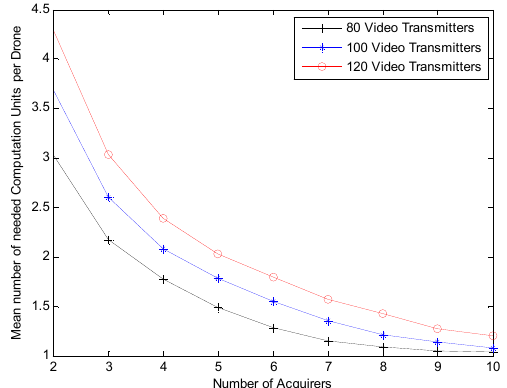
Figure 10. Mean number of needed computational units per drone versus the number of acquirers.